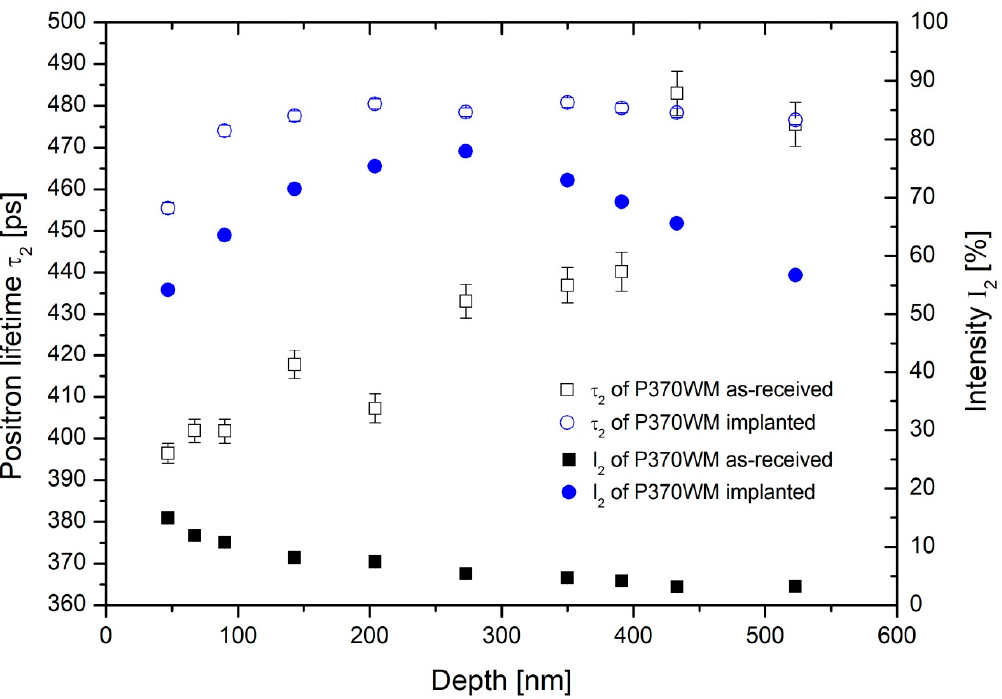
Figure 4. Comparison of PLEPS parameters in two components analyze of specimen P370 WM, before and after H + implantation by 100 keV (maximal damage at about 12 keV corresponding to depth of about 400–450 nm). Lifetimes and intensities of second component are presented.